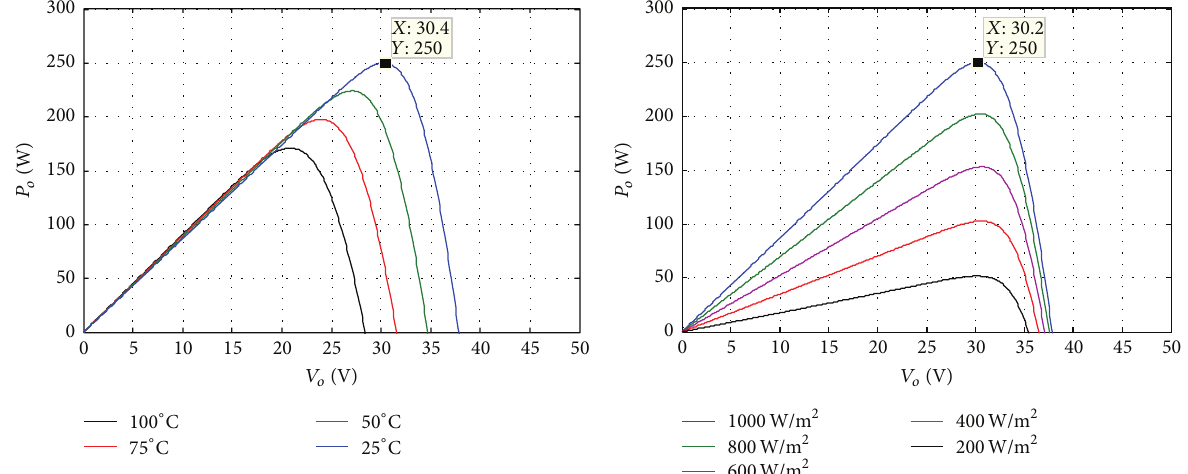
Figure 9: V - P curves evaluating values of 𝐸 mean and 𝑇 𝐽